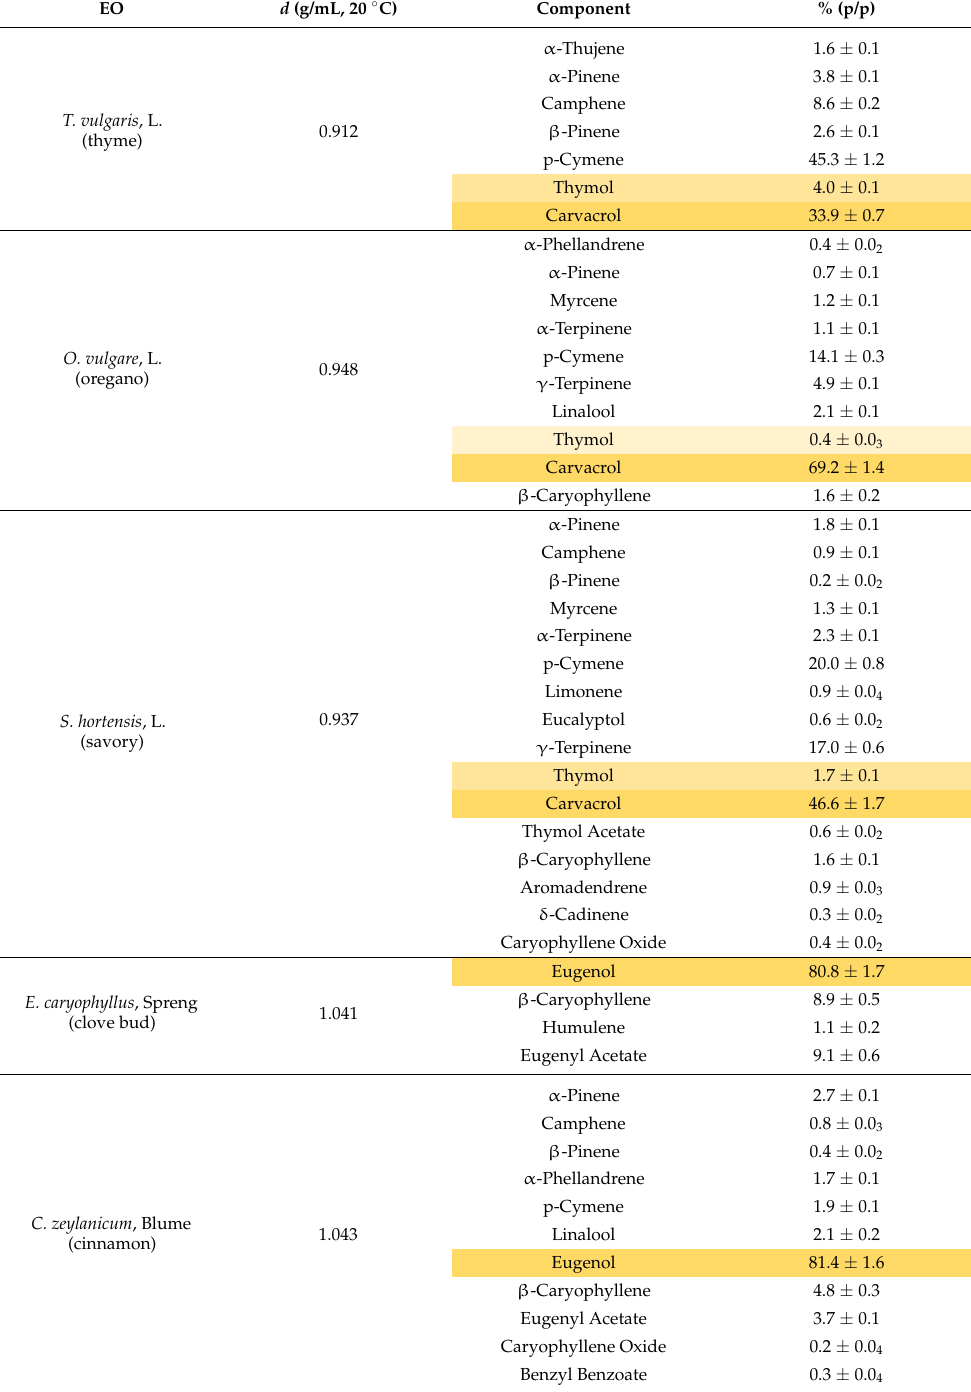
Table 1. Composition of the investigated EOs, identified by CG-MS analysis. Concentrations are expressed as % peak area ( ± SD, n = 3) in the chromatogram from GC-FID analysis. EO d (g/mL, 20 ◦ C)